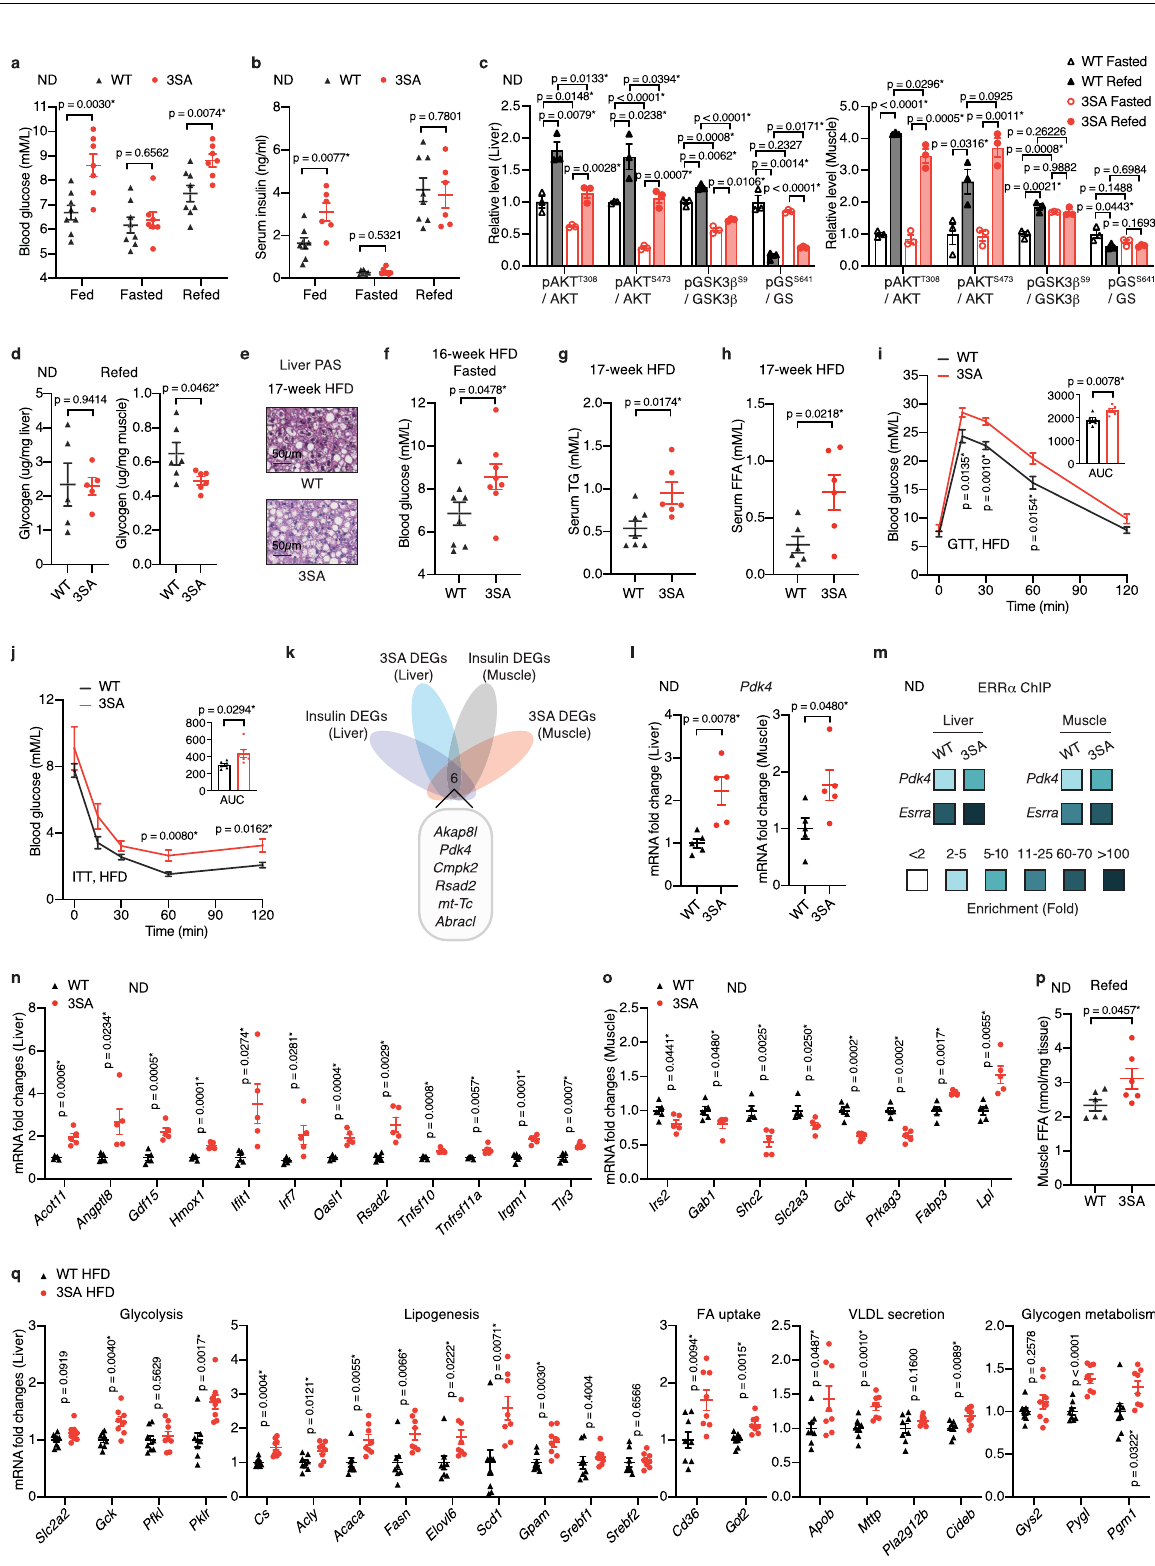
HFD-fed ERR α 3SA mice. Mechanistically, C29 enhances skeletal muscle glucose oxidation while inhibiting hepatic glucose production. Simultaneously, C29 inhibits hepatic glycolysis and FA uptake, limiting the precursors for TG synthesis. C29 further promotes hepatic TG clearance by augmenting FAO and concomitantly decreases circulating TG by suppressing VLDL